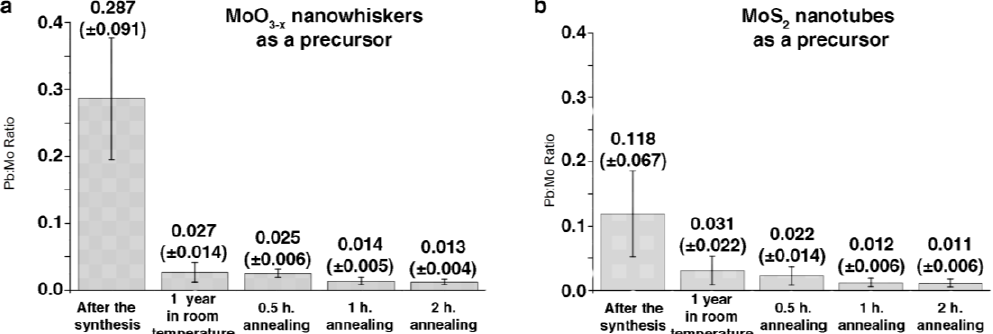
Figure 2. Pb:Mo ratio of the precursors and products according to the EDS measurements, ( a ) MoO (2) nanowhiskers as a precursor material; ( b ) MoS 3− x precursor